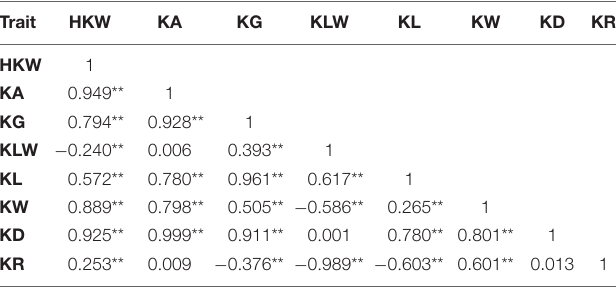
TABLE 2 | Correlation coefficients among cotton seed size and shape-related traits in the BIL population.